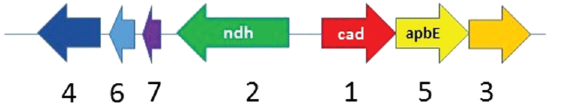
Figure 1: Illustration of the applied work